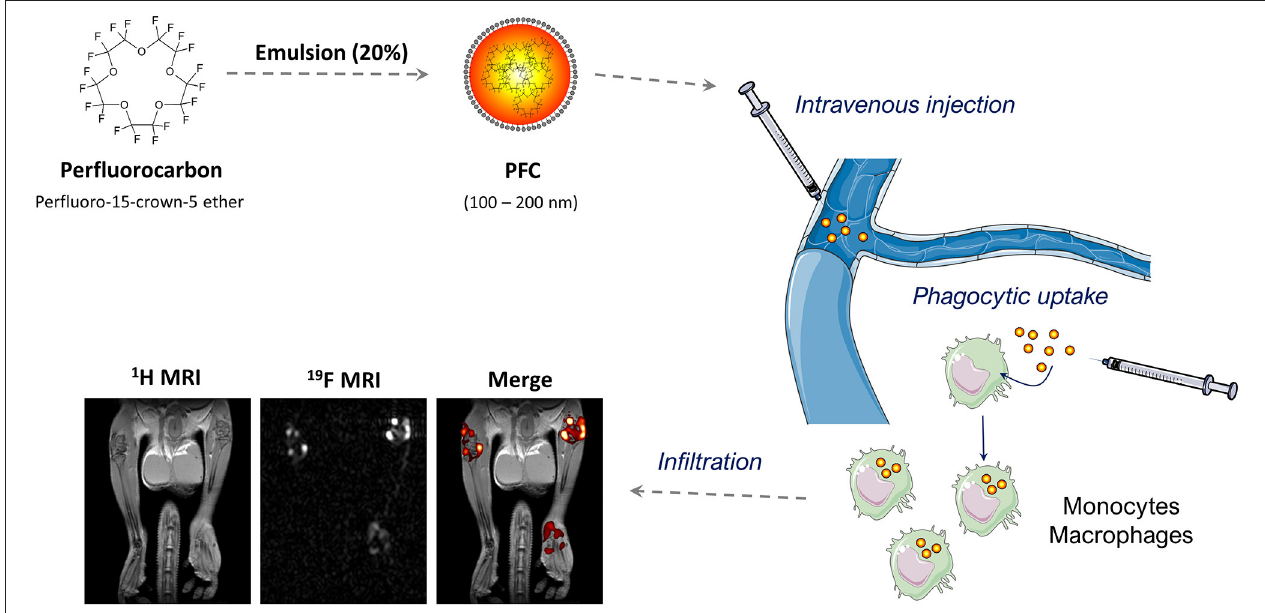
FIGURE 4 | 19 F MRI-based inflammation imaging: Perfluorocarbons are emulsified by high-pressure homogenization to generate perfluorocarbon nanoemulsions (PFCs) with a size between 100 and 200nm. Intravenous injection of PFCs leads to cellular uptake by circulating or local phagocytic immune cells—particularly monocytes and macrophages. The accumulation of these cells is detected by combined 1 H/ 19 F MRI. The MRI images show the anatomy of legs and hips of a male mouse with collagen-induced arthritis (left), the corresponding 19 F dataset (middle) and a merging of both (right). Note that the merged image reveals the anatomical localization of the phagocytic immune cells. 1 H/ 19 F MRI images were adapted from Flögel et al. ( 156), and elements of the schematic figures were derived from: